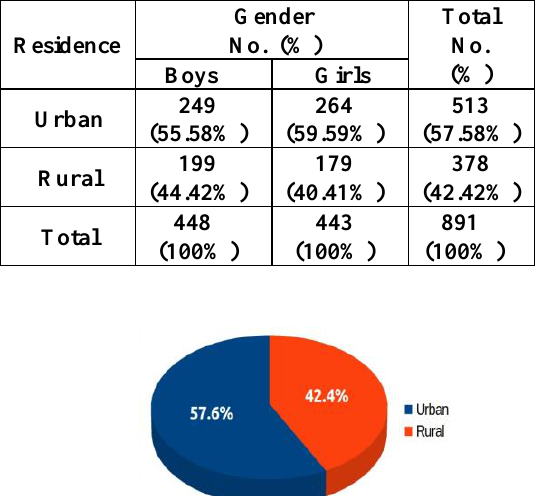
Table 1: Distribution of the children